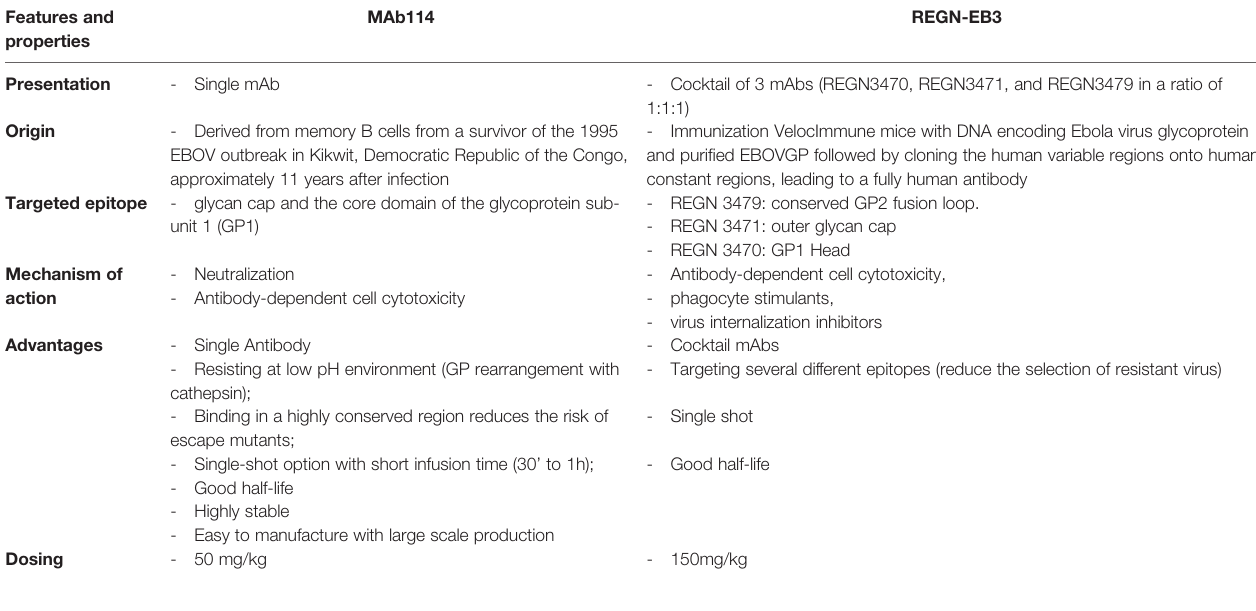
TABLE 1 | Brief comparison of mAb114 and REGN-EB3